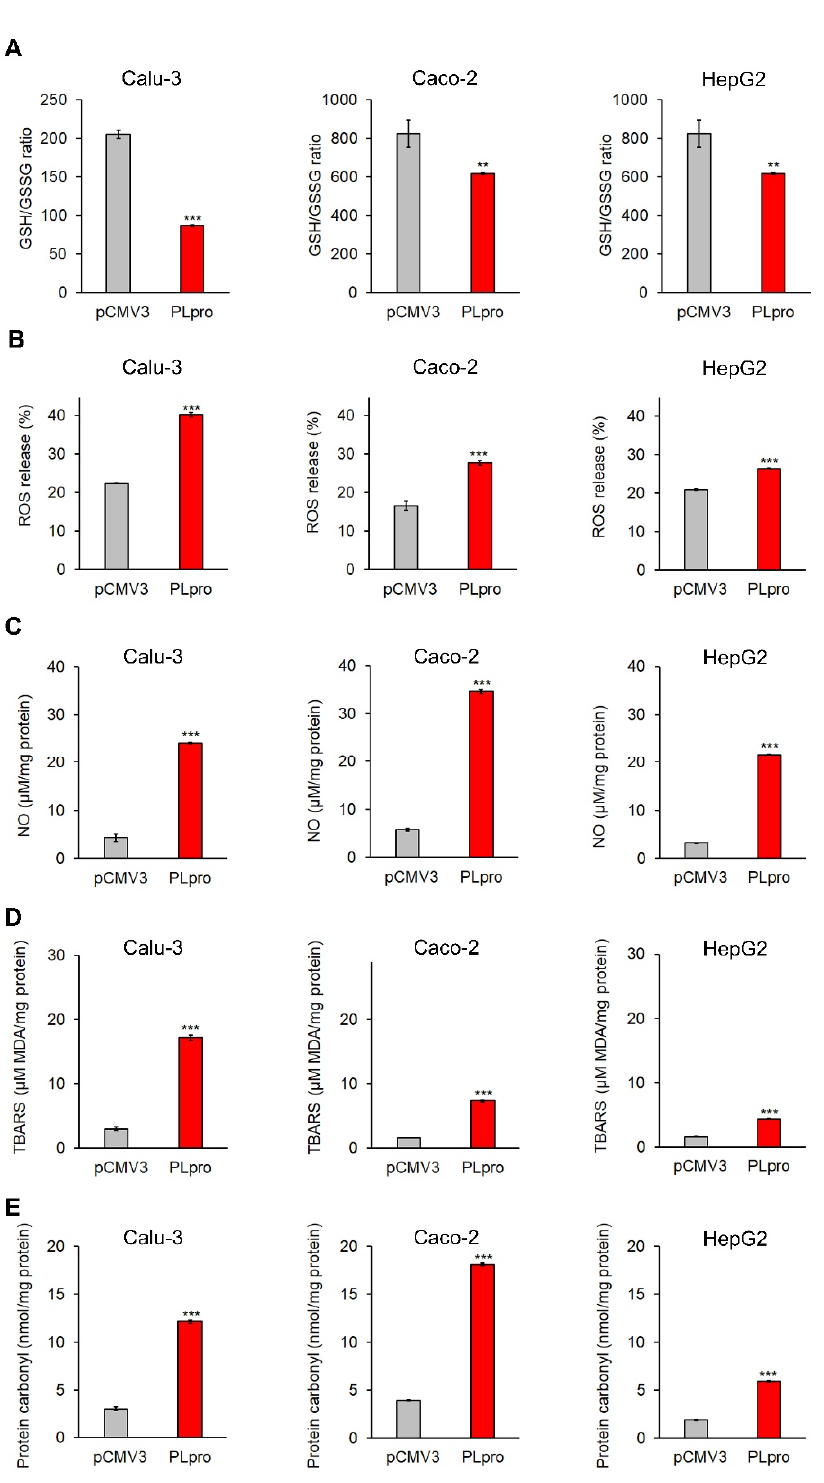
Figure 6. PLpro expression causes pro-oxidant response in epithelial cells. The histograms report GSH/GSSG ratio ( A ), percentage of ROS release ( B ), and levels of NO ( C ), TBARS ( D ) and protein carbonyl ( E ) in Calu-3, Caco-2 and HepG2 cells expressing PLpro (PLpro) compared to empty vector (pCMV3). Values are plotted as mean ± SD of two independent experiments repeated in duplicate. Data were analyzed by 2-tailed t -tests, ** p <0.01, *** p <0.001 vs. pCMV3.